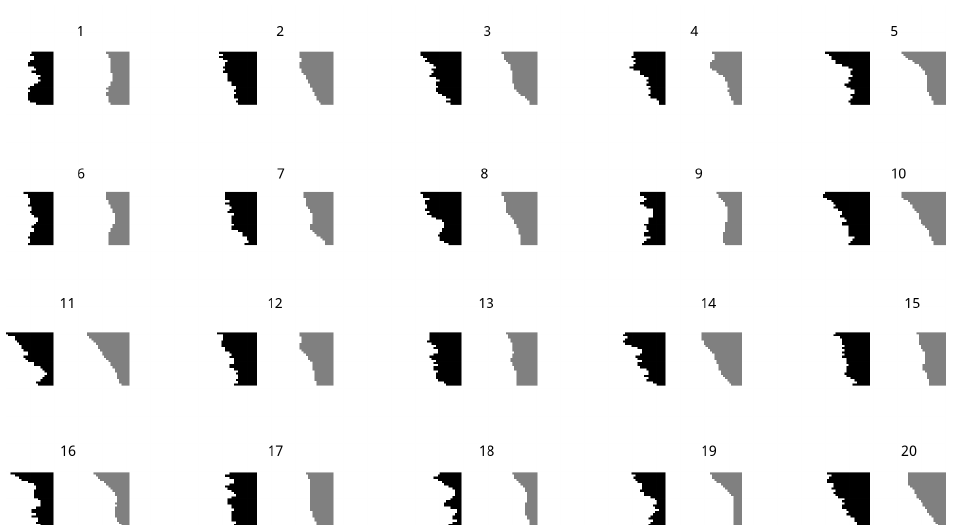
Figure 8. Some input geometries (in black on the left side) and the corresponding VAE reconstruction (in gray on the right side).